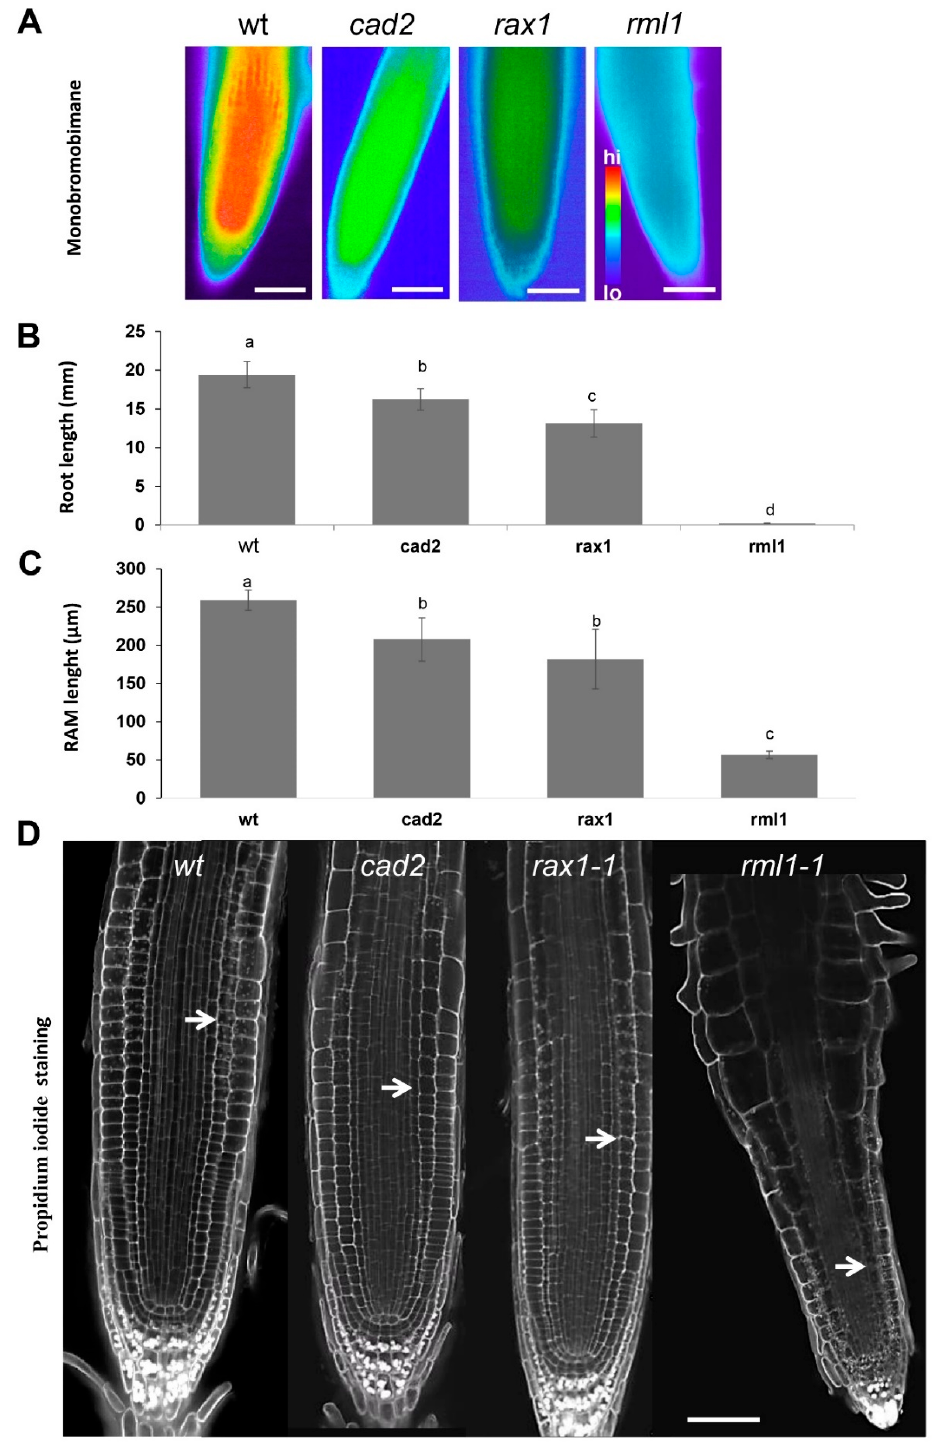
Figure 1. Root traits of wild type, cad2 , rax1 , and rml1 mutants. ( A ) Semi-quantitative analysis of low molecular weight thiols using fluorescent in situ labeling with bromobimane. Scale bars represent 20 µm; ( B ) Root length after seven days of growth. Error bars represent the means ± SDs ( n = 8); ( C ) Length of the root apical meristem at seven days after germination. Error bars represent the means ± SDs ( n = 8). Different letters indicate a significant difference at p < 0.05. Fisher’s protected LSD test was used to compare the individual means; ( D ) root apical meristem (RAM) structure after propidium iodide (PI) staining. White arrow indicates the end of meristematic zone borders; Scale bars represent 100 µm.